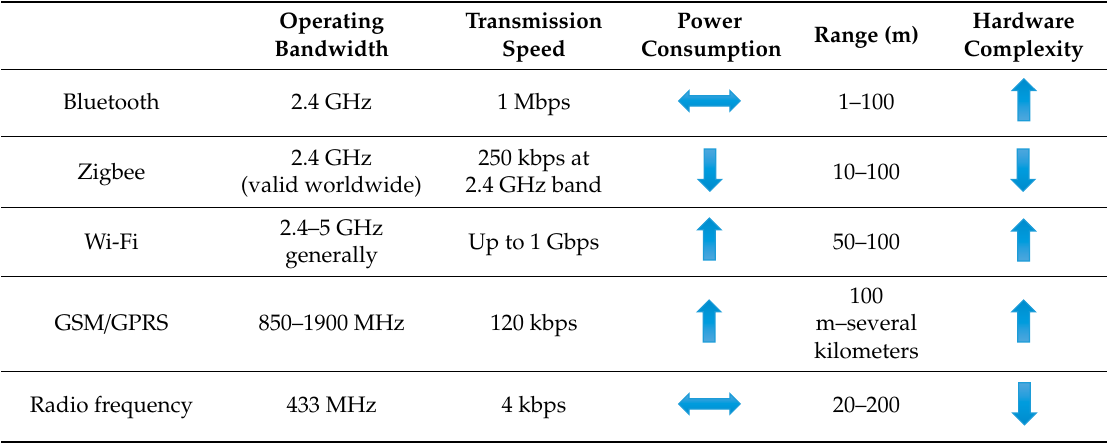
Table 3. Comparison of the main transmission technologies used in respiratory monitoring systems [237].